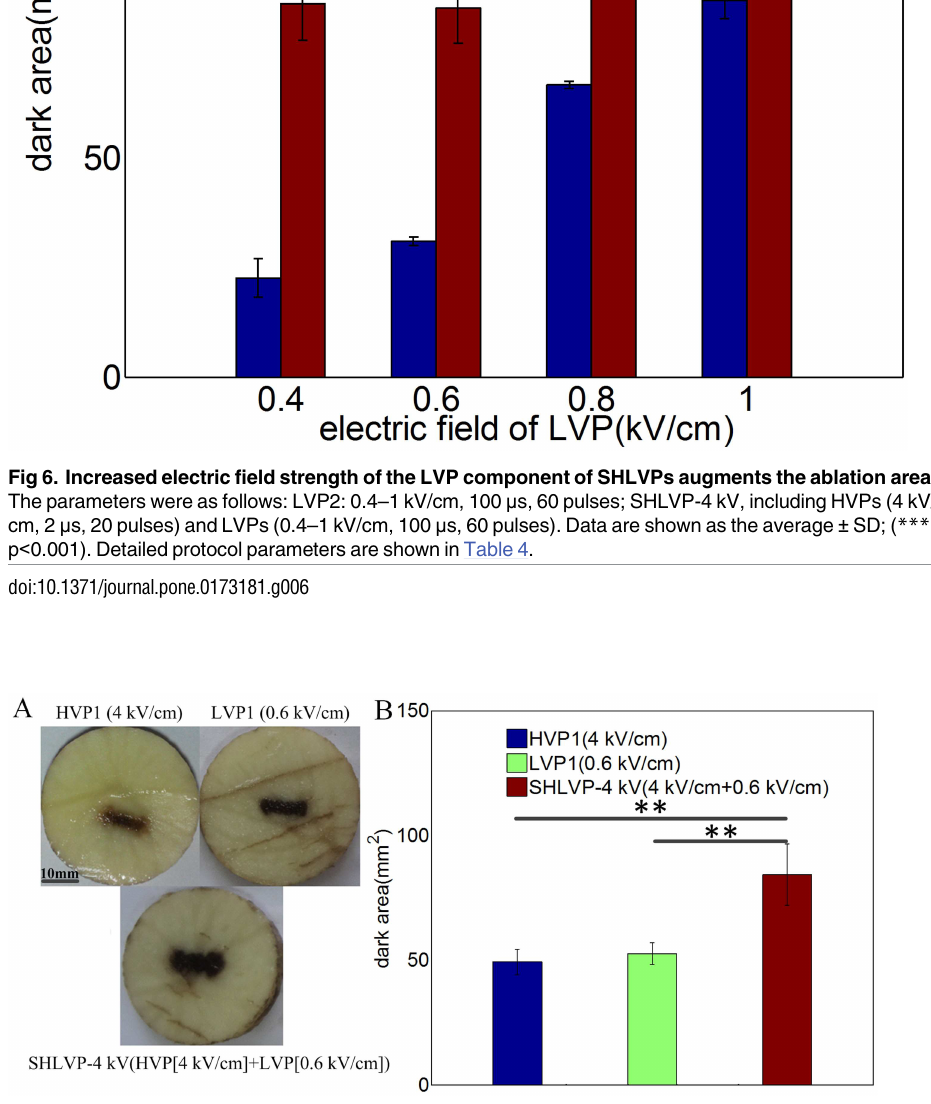
Fig 7. Comparison of ablation regions with the same pulse number subjected to HVP1, LVP1 and SHLVP-4 kV (HVP+LVP) pulsation. A: Images of the ablatedregions. B: The mean ablatedregions (dark areas) depictedin A. Parameters: HVP1 (4 kV/cm, 2 μ s, 80 pulses); LVP1 (0.6 kV/cm, 100 μ s, 80 pulses); and SHLVP-4 kV (4 kV/cm, 2 μ s, 20 pulses+0.6kV/cm, 100 μ s, 60 pulses). Data are shown as the average ± SD ( ** , p < 0.01).Detailedprotocol parameters are shown in Table 5.